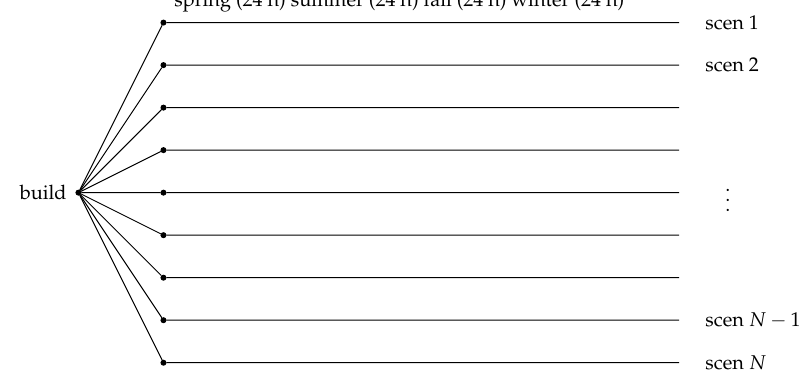
Figure 3. A scenario fan for 96 h representing a